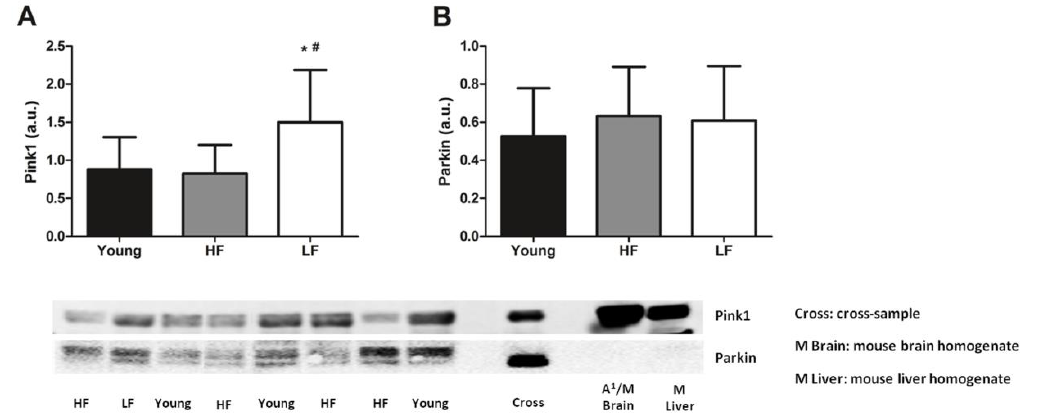
Figure 5. Protein levels of selected markers of mitophagy in the vastus lateralis muscle of young and old participants. Comparison by one-way ANOVA of ( A ) phosphatase and tensin homolog-induced kinase 1 (Pink1) and ( B ) Parkin among young participants ( n = 11) and high- (HF, n = 16) and low-functioning (LF, n = 7) older adults. Bars represent mean values ( ± standard deviation) for the three experimental groups. Values are expressed in arbitrary units (a.u.) and representative blots are shown for each protein. * p < 0.05 vs. young group. # p < 0.05 vs. HF group.